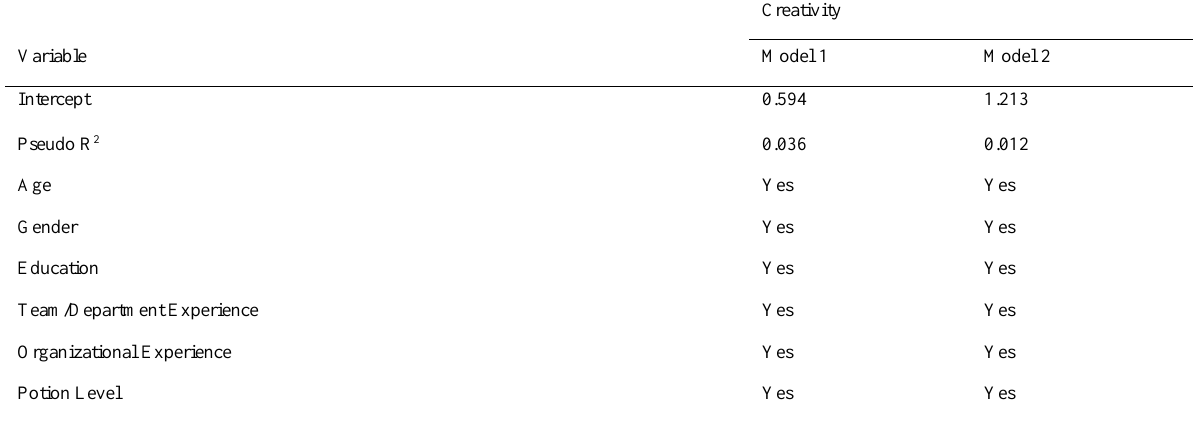
Table 2: Summary of regression analysis for workplace loneliness predicting employee